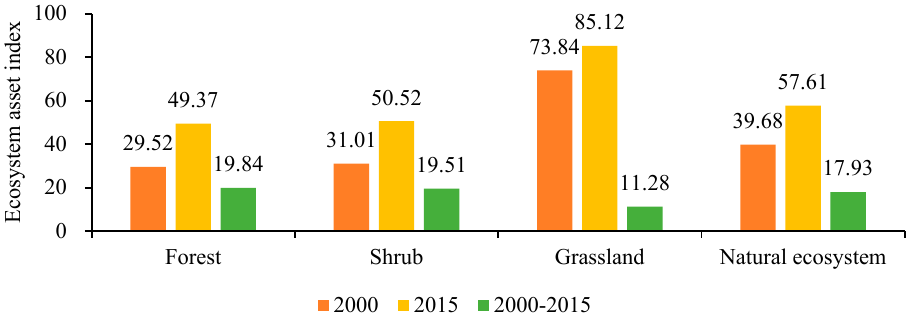
Figure 11. Natural ecosystem asset index and its change in the Beijing–Tianjin–Hebei urban agglom- eration from 2000 to 2015.